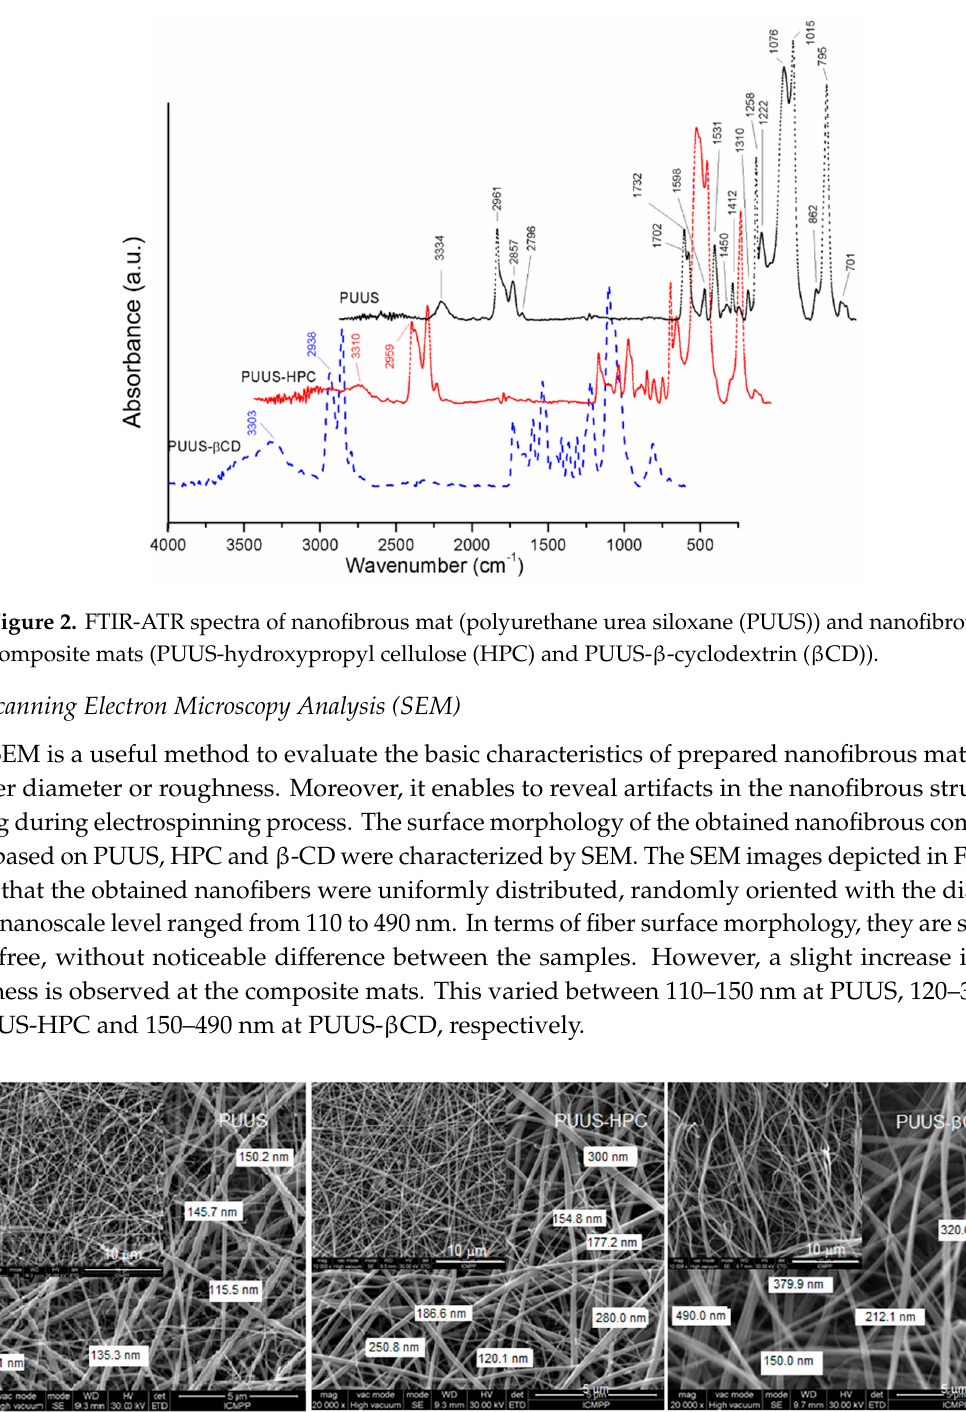
Figure 3. SEM images of nanofibrous mat (PUUS) and nanofibrous composite mats (PUUS-HPC and PUUS- β CD).